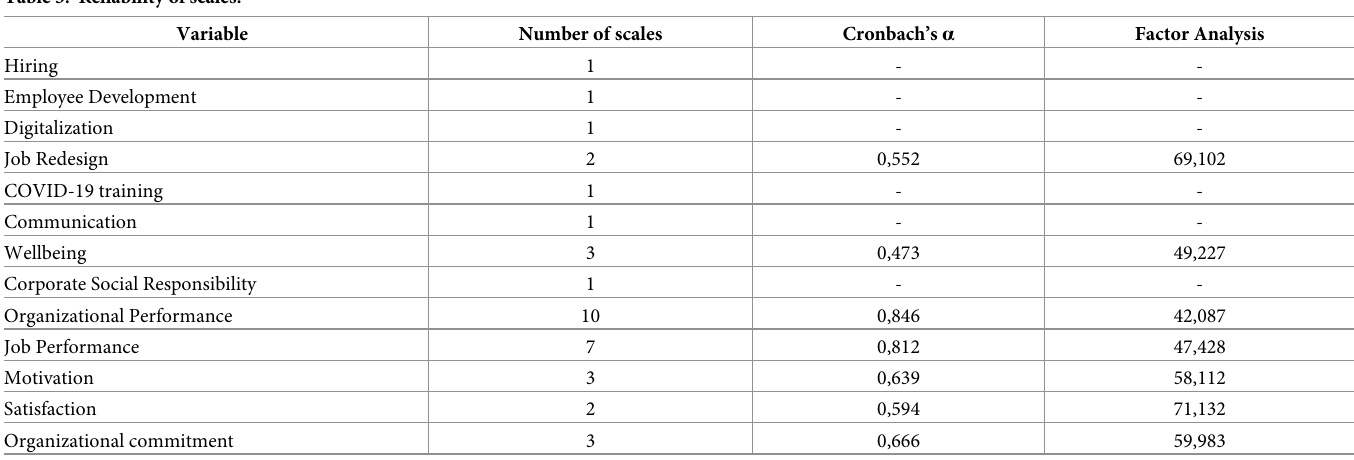
Table 3. Reliability of scales.